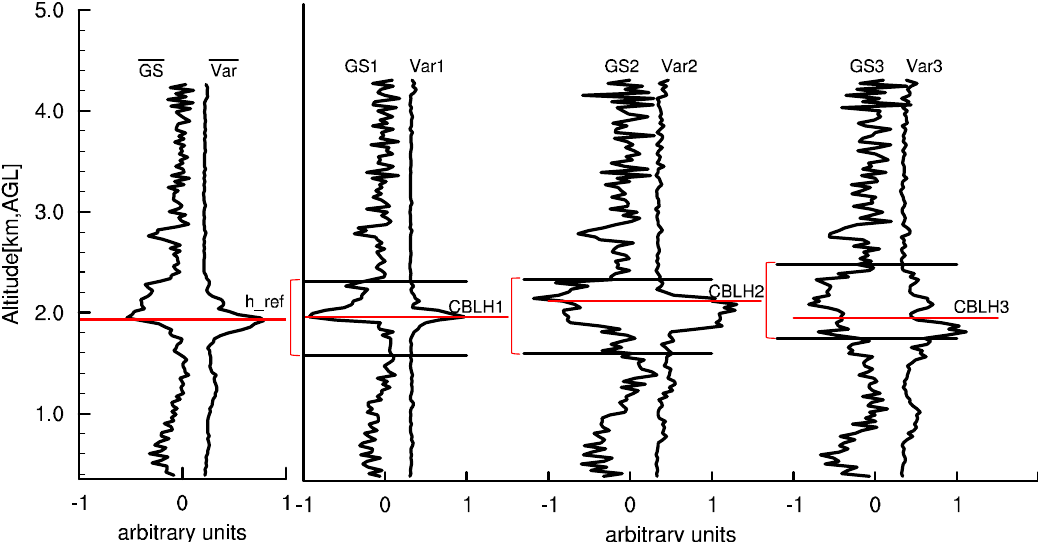
Figure 9. Flowchart for the combination of the VAR and GM in Hennemuth and Lammert [42].